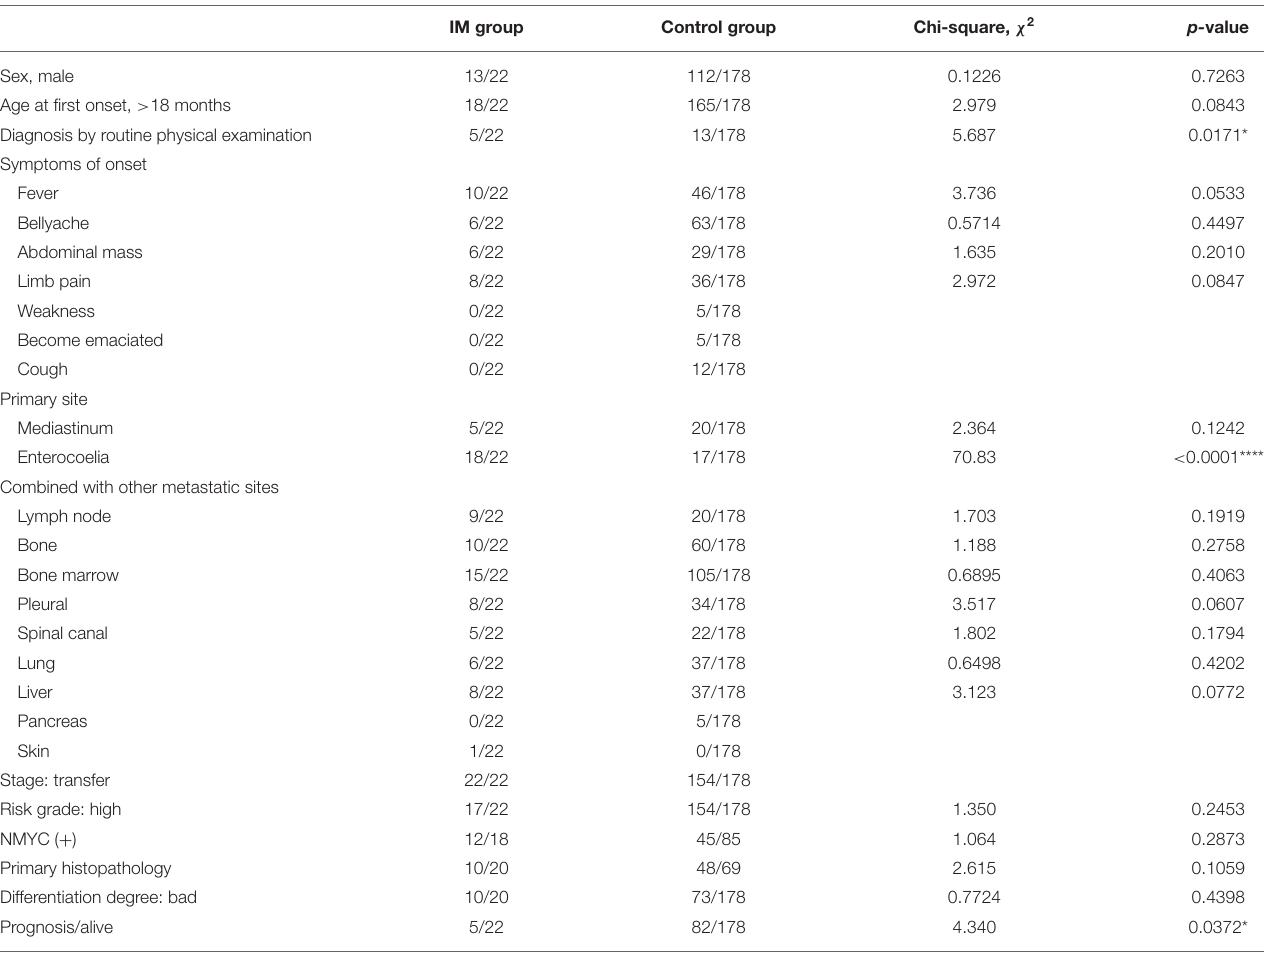
TABLE 1 | Demographic and clinical characteristics of NB with and without